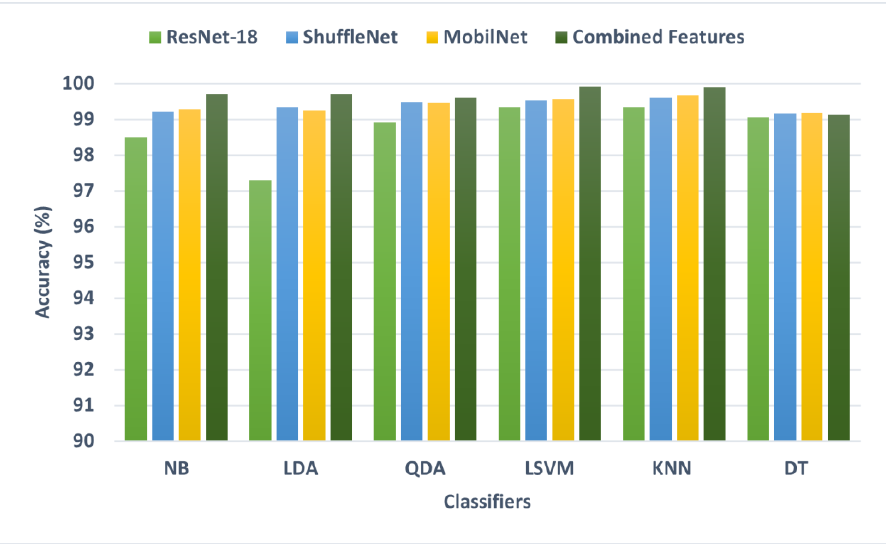
Figure 3. The classification accuracy (%) of the six ML classifiers after feature concatenation. Table 3. The classification results (%) for the six ML classifiers fed with the combined features after the concatenation step .